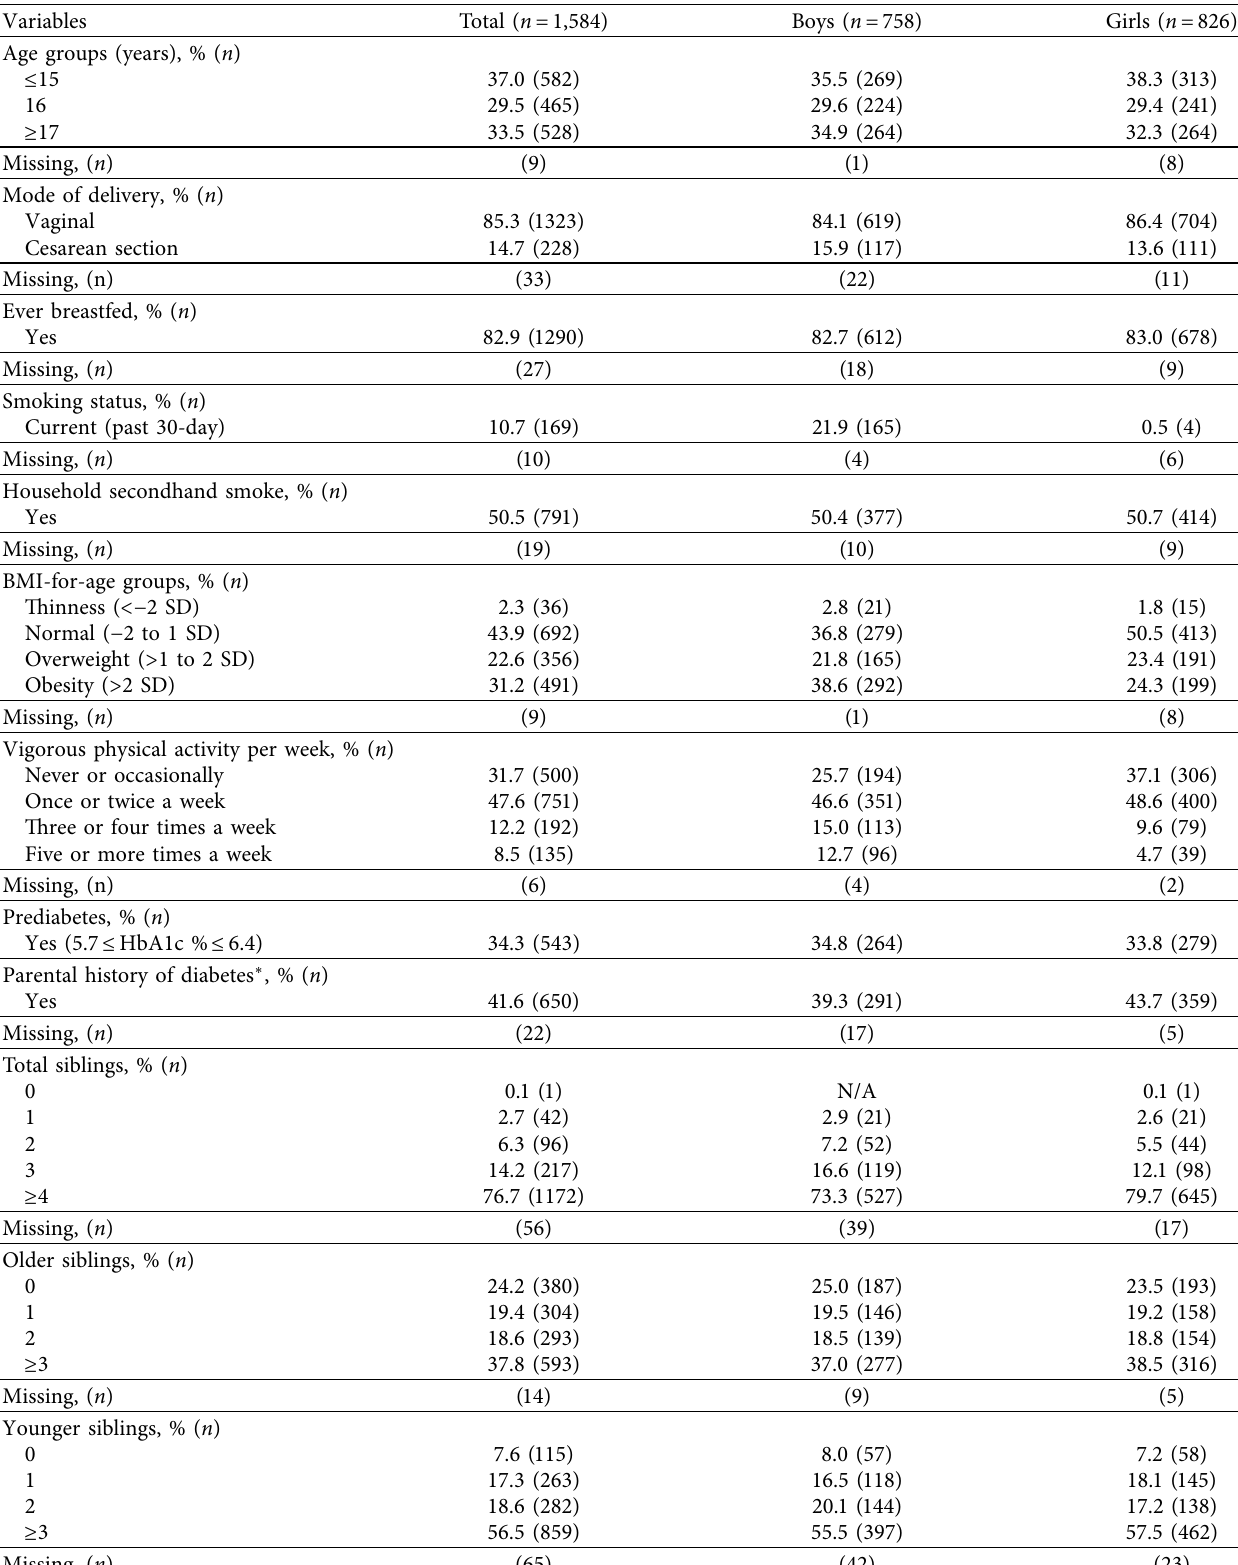
Table 1: Characteristics of the study participants in the total sample and stratified by